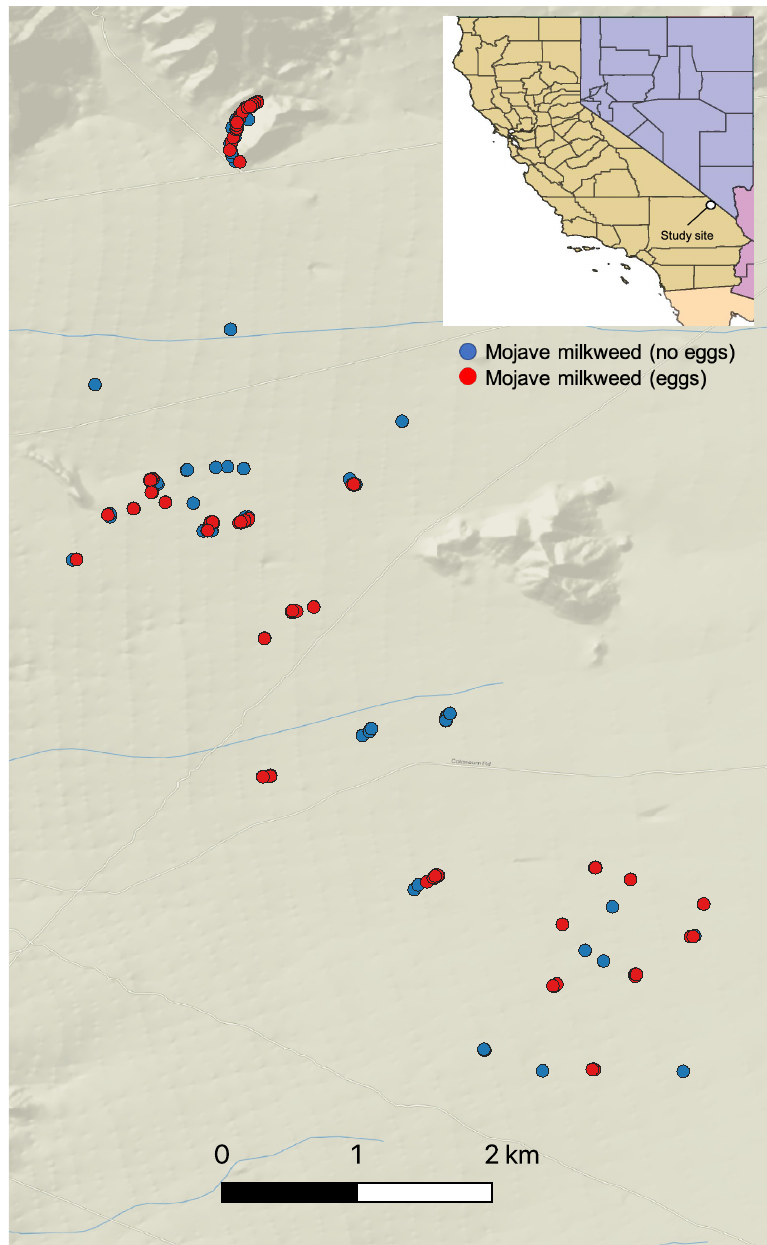
Figure 1. Distribution of Mojave milkweed plants without queen butterfly eggs (Mojave milkweed—no eggs, n = 304) and with at least 1 queen butterfly egg (Mojave milkweed—eggs, n = 115) recorded throughout the spring season, 27 April–1 June 2017, Ivanpah Valley, Mojave Desert, California, USA. Given the clustering of Mojave milkweed populations, individual Mojave milkweed points are not all visible. This map includes presence / absence of queen butterfly eggs on Mojave milkweed only, whereas aggregation analyses used egg count data per plant. Inset: Location of study site (white dot) in the United States. Map by Steve